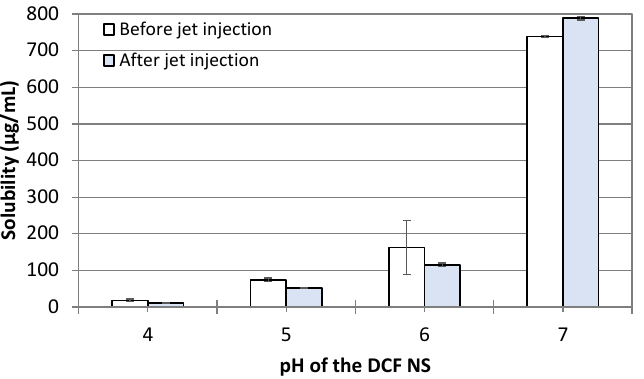
Figure 4. Saturation solubility of DCF NS in deionized water at 37 °C before and after the jet injection across a skin specimen. Bars represent the average ± standard deviations of n = 3 independent meas- urements.